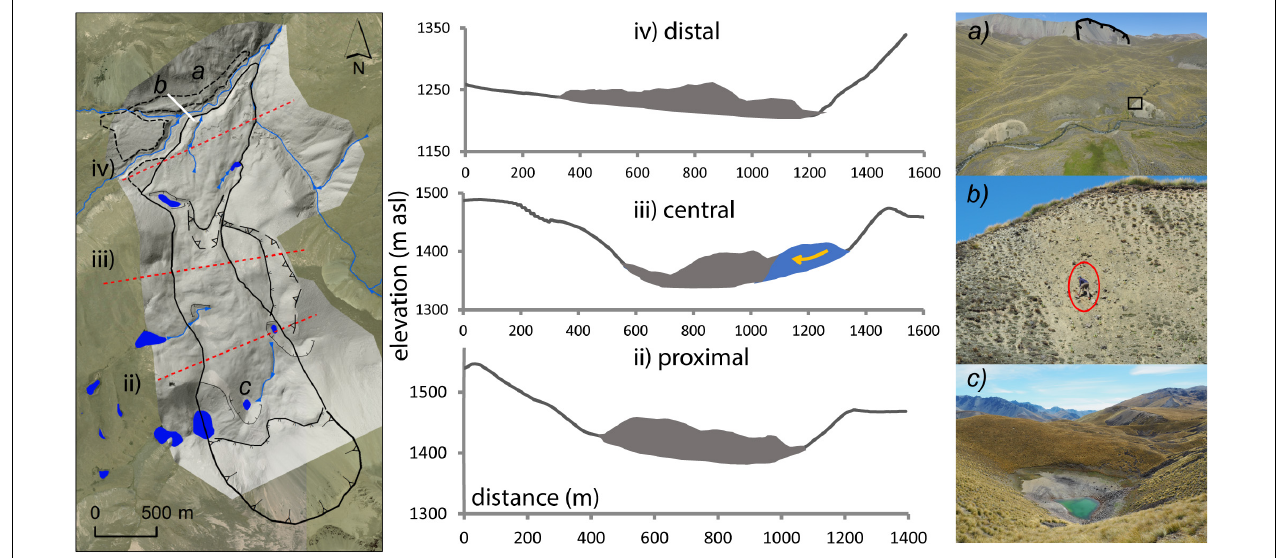
FIGURE 4 | Cross-sections ii-iv of rock avalanche deposit with locations of the sections and field photos indicated on map on the left. Photo (a) looking southwards with a view of Bush Stream in the middle distance and the source area crown (marked as black scarp) on the horizon. (b) Exposed rock avalanche sediments along Bush Stream (approx. photo position shown with black rectangle in photo (a) , showing the lack of stratification and poor sorting of deposit. (c) One of the depressions with a small lake within the rock avalanche deposit, with location indicated on the map on